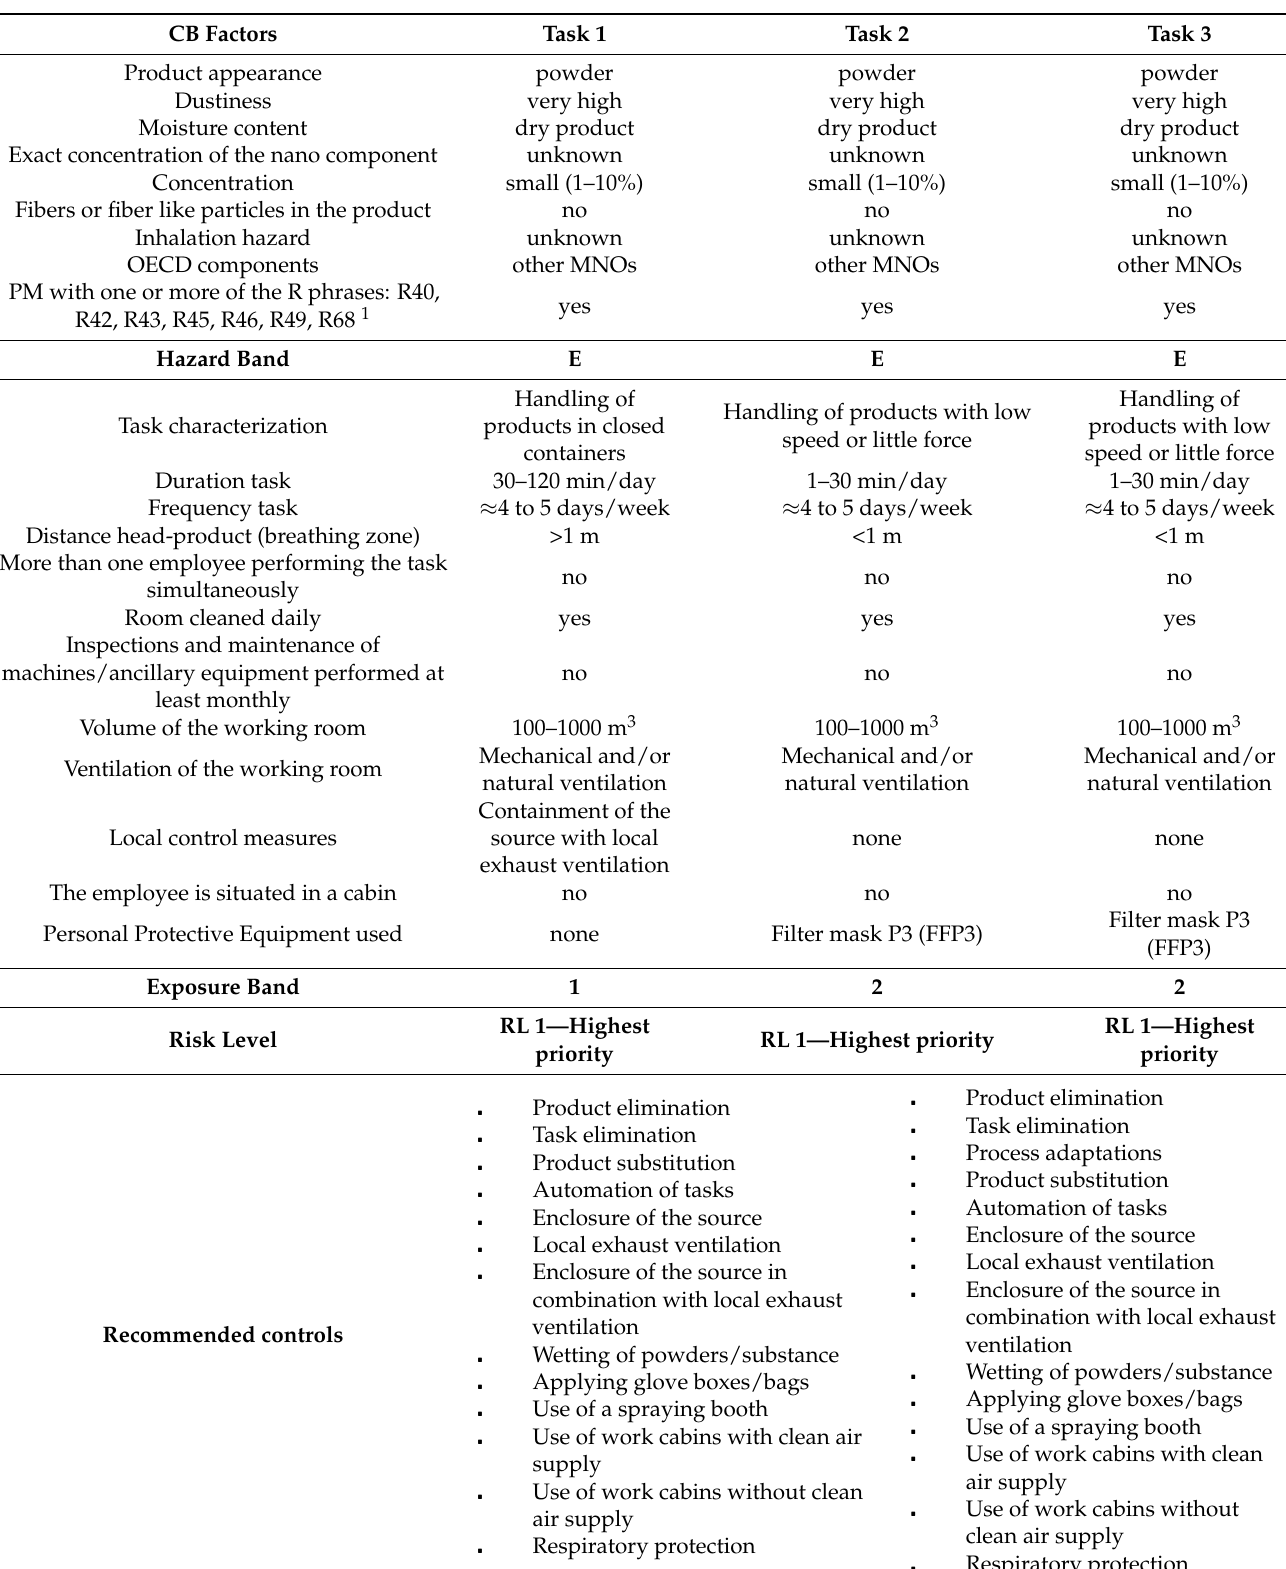
Table 6. Results of the application of Stoffenmanager Nano